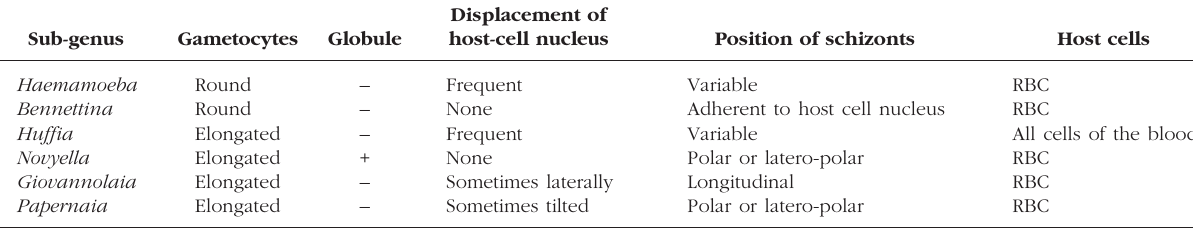
Table I. – Main distinctive characteristics of avian Plasmodium sub-genera. RBC = red blood